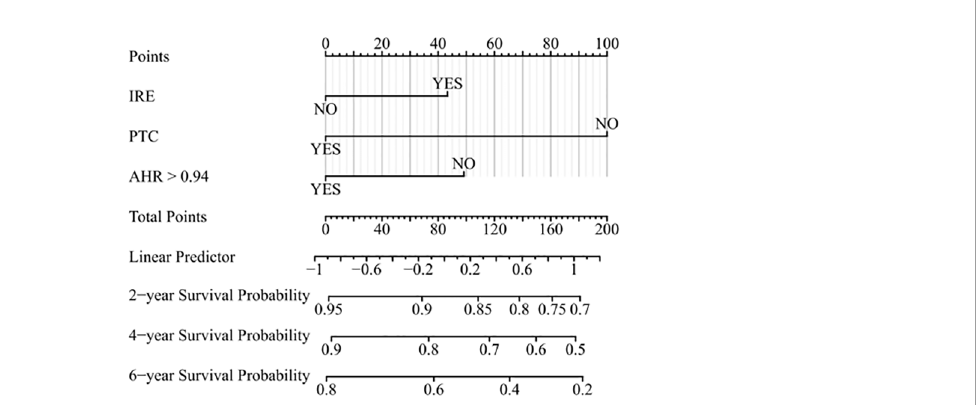
FIGURE 4 Prognostic nomogram for predicting OS of patients treated with PA-TACE. OS, overall survival; PA-TACE, postoperative adjuvant transarterial chemoembolization; IRE, rim-like arterial phase enhancement; PTC, peritumor capsule; AHR, alanine aminotransferase to hemoglobin ratio.